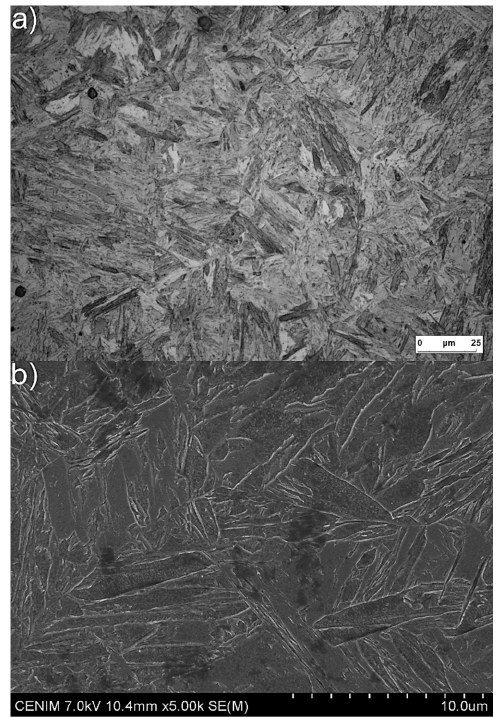
Figure 6. Martensitic microstructures of steel after quenching: ( a ) light microscopy (LM) and ( b ) scanning electron microscopy (SEM).